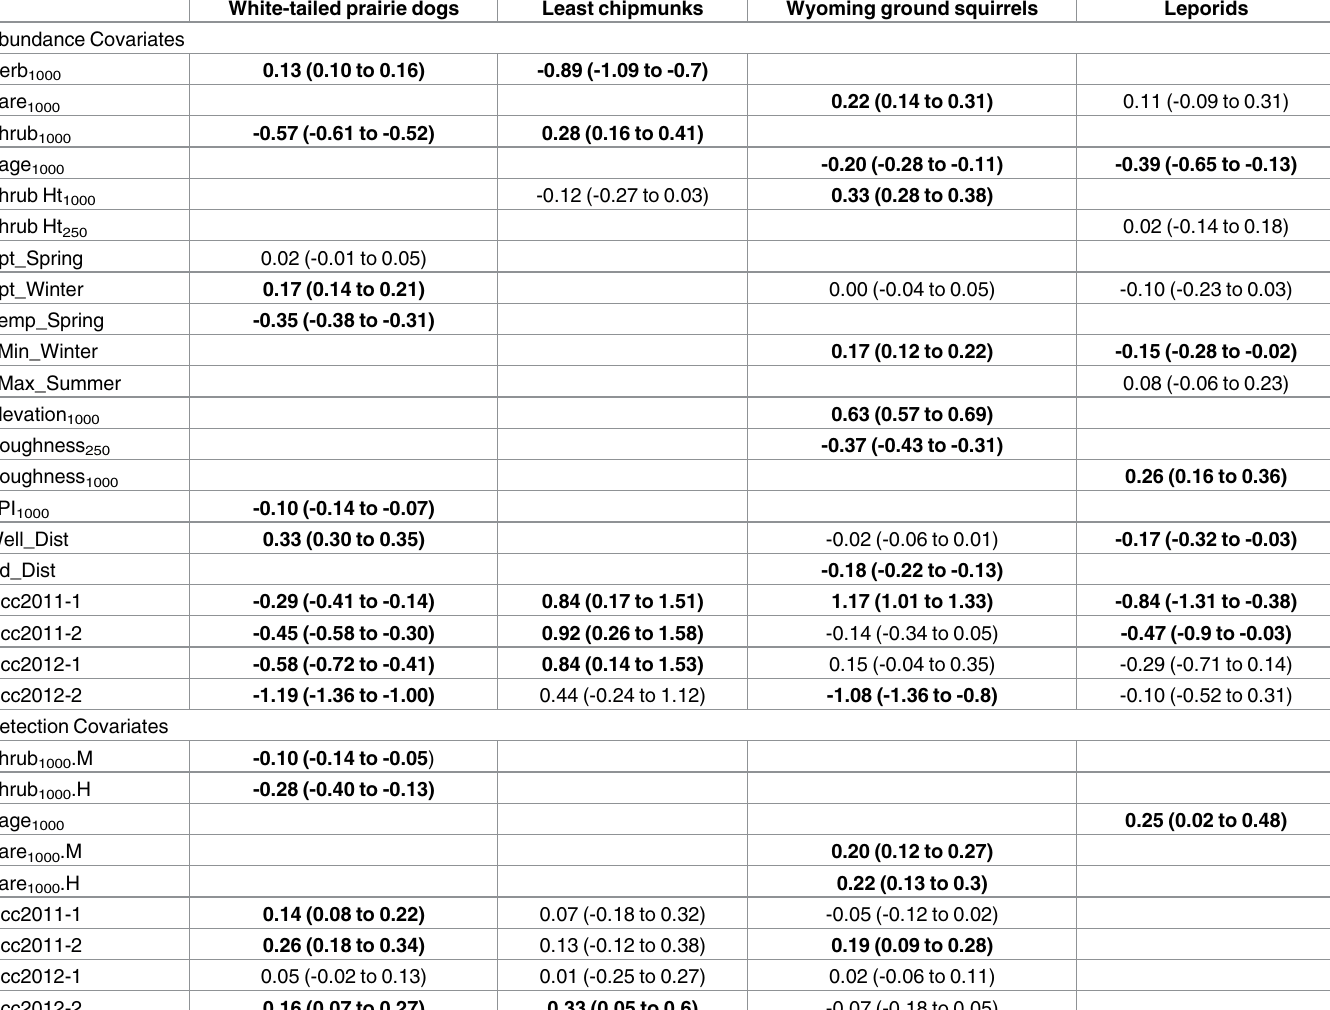
Table 6. Standardized beta coefficients for the top performing distance model for each modeled small mammal species group from line transect surveysin Wyoming, 2010–2012. White-tailed prairie